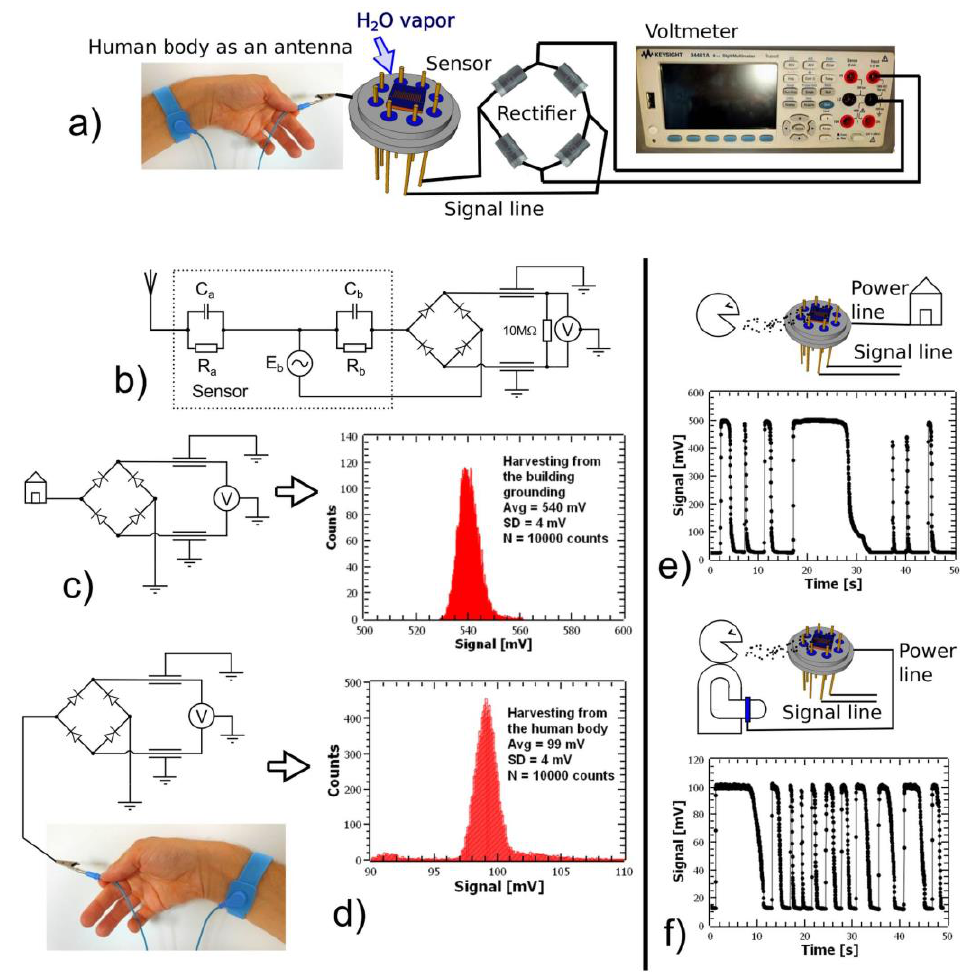
Figure 3. ( a ) Illustration of the breath humidity sensor powered by EM energy harvested from the human body; ( b ) Equivalent schematic of the sensor together with the antenna, rectifier and voltmeter; ( c ) Rectification of the voltage obtained by EM energy harvesting using a wire connected to the building foundation ( left ) and histogram of the recorded signal ( right ); ( d ) Rectification of the voltage coming from the EM energy harvested from the human body using an antistatic wrist strap ( left ) and histogram of the recorded signal ( right ); ( e ) Direct breath-blow on the sensor surface and signal from the voltmeter. The EM harvesting was realized by using a wire connected to the building foundation; ( f ) Direct breath-blow on the sensor surface and the signal from the voltmeter. The EM energy was sourced from the human body by using an antistatic wrist strap. The ambient humidity during all measurements was 35% RH. 2.5. EM Energy Harvesting Quantification In order to quantify the influence of EM energy harvesting on the sensor’s output signal, the voltage from the EM harvesting antenna was rectified using the full bridge Schottky rectifier, whose output was connected to the input of the voltmeter, Figure 3c,d. The same procedure was performed for the EM energy harvesting realized by using a wire connected to the building foundation, Figure 3c, and the EM energy harvesting from the human body using an antistatic wrist strap on the volunteer’s arm, Figure 3d. The signal harvested from the building foundation has a histogram with the average value of 540 mV, and standard deviation of 4 mV (statistics calculated based on 10,000 measurements). The signal harvested from the human body, using an antistatic wrist strap as a contact between the sensor housing and the volunteer’s body, has a histogram with the average value of 99 mV, and standard deviation of 4 mV (statistics calculated based on 10,000